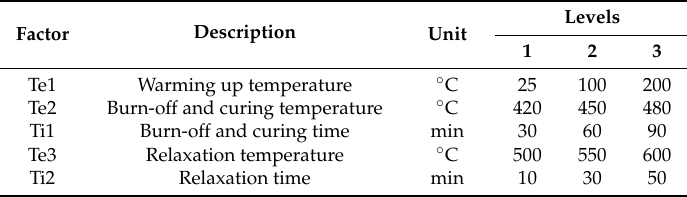
Table 3. An orthogonal array and experimental results for the heat treatment of SMC cores.